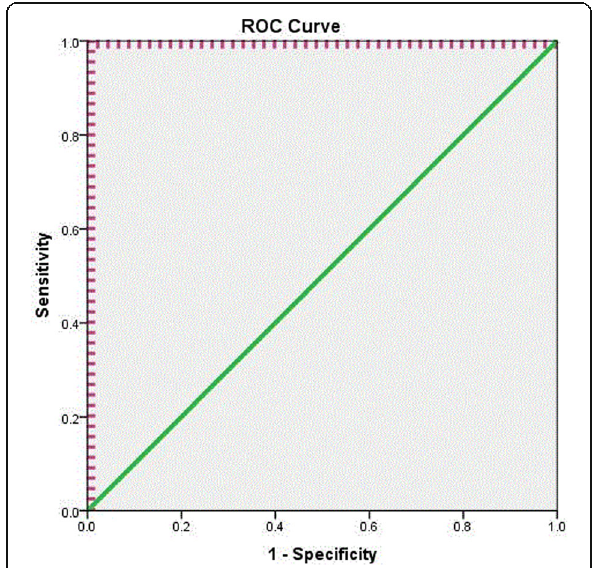
Fig. 1 ROC curve analysis of KL6 between stable and exacerbation